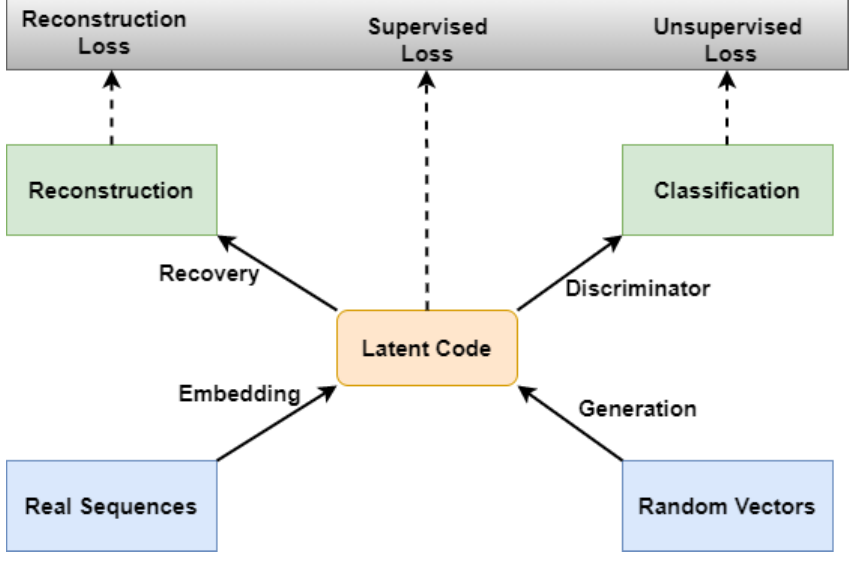
Figure 2. Time-GAN architecture.